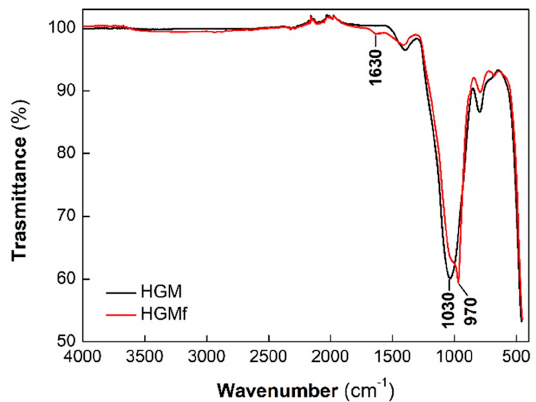
Figure 2. FTIR spectra of naked HGM and HGM functionalized with APTES.